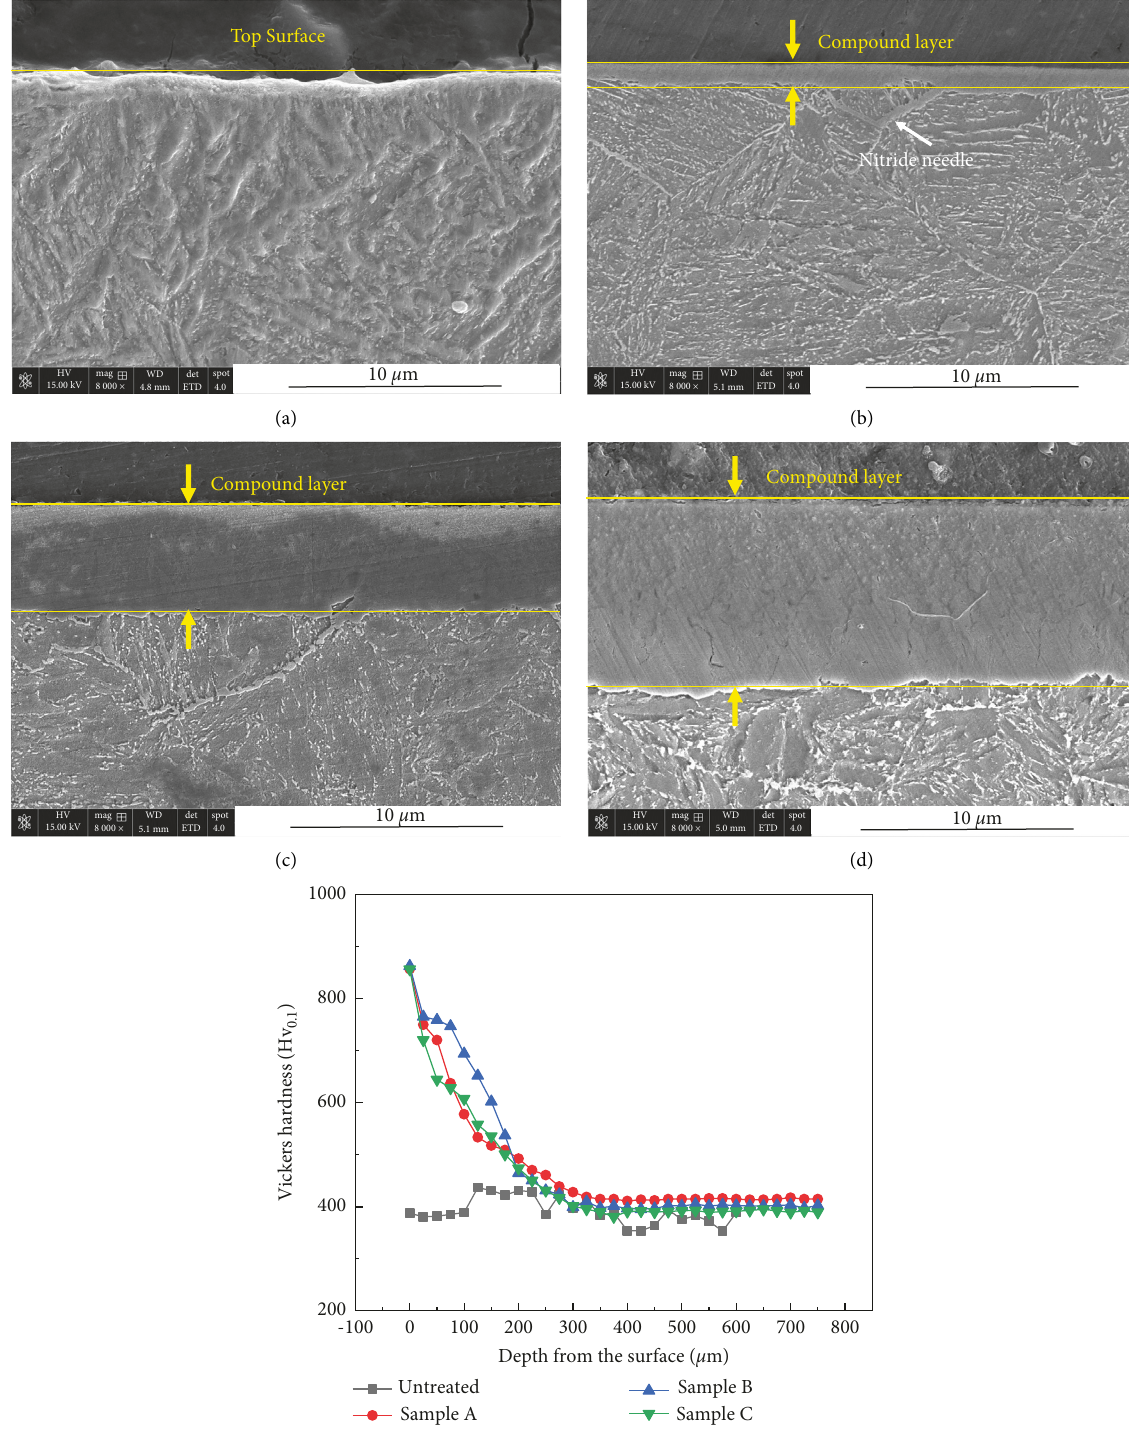
Figure 2: SEM images and hardness profiles of the cross-sectional microstructure of (a) Untreated, (b) Sample A, (c) Sample B, and (d) Sample C. (e) Vickers hardness